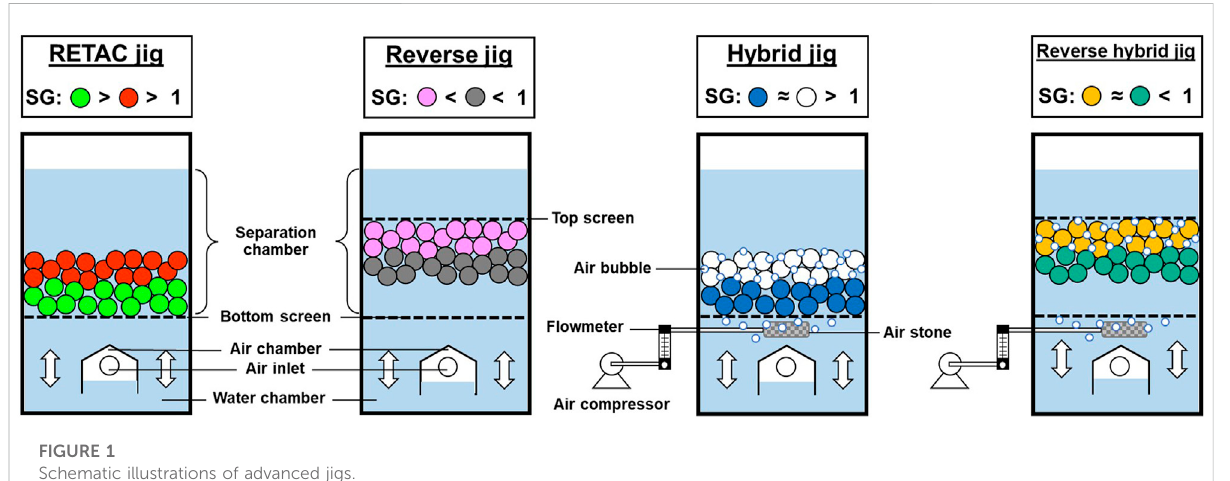
FIGURE 1 Schematic illustrations of advanced